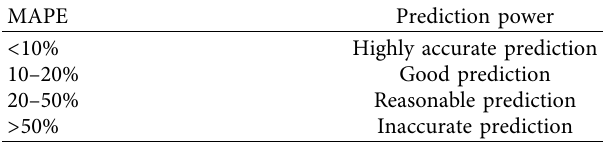
Table 4: MAPE criteria.